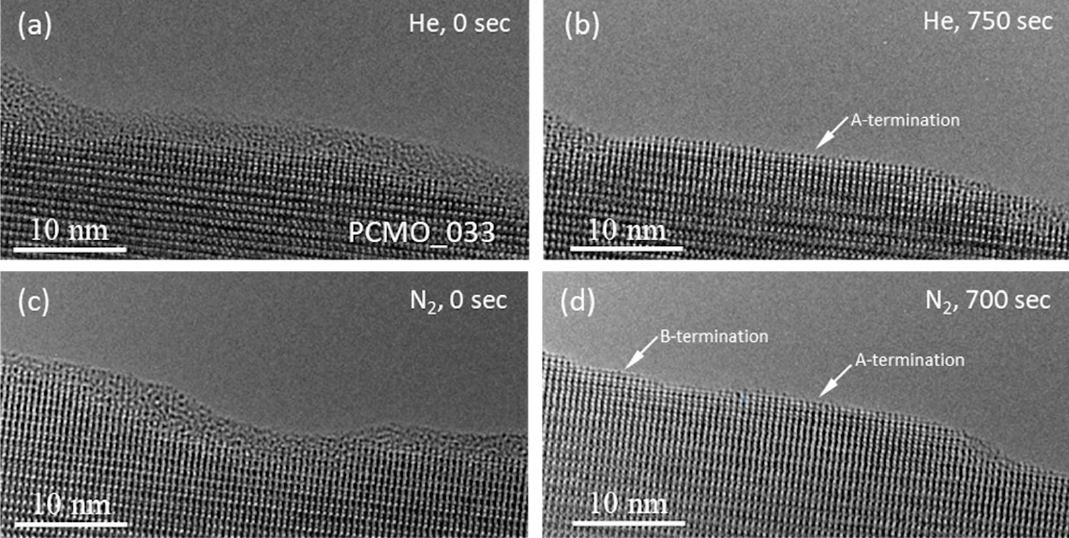
Figure 2. HRTEM images of an edge of Pr 1-x Ca x MnO 3 (PCMO) (x = 0.33) material in He (p He = 50 ubar) at the beginning ( a ), after 750 sec ( b ), and in N 2 at the beginning ( c ) and after 700 sec ( d ), respectively.